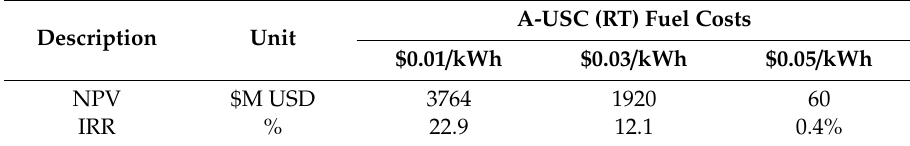
NPV and IRR comparison of A-USC with di ff ering fuel rates assuming $1409 M initial